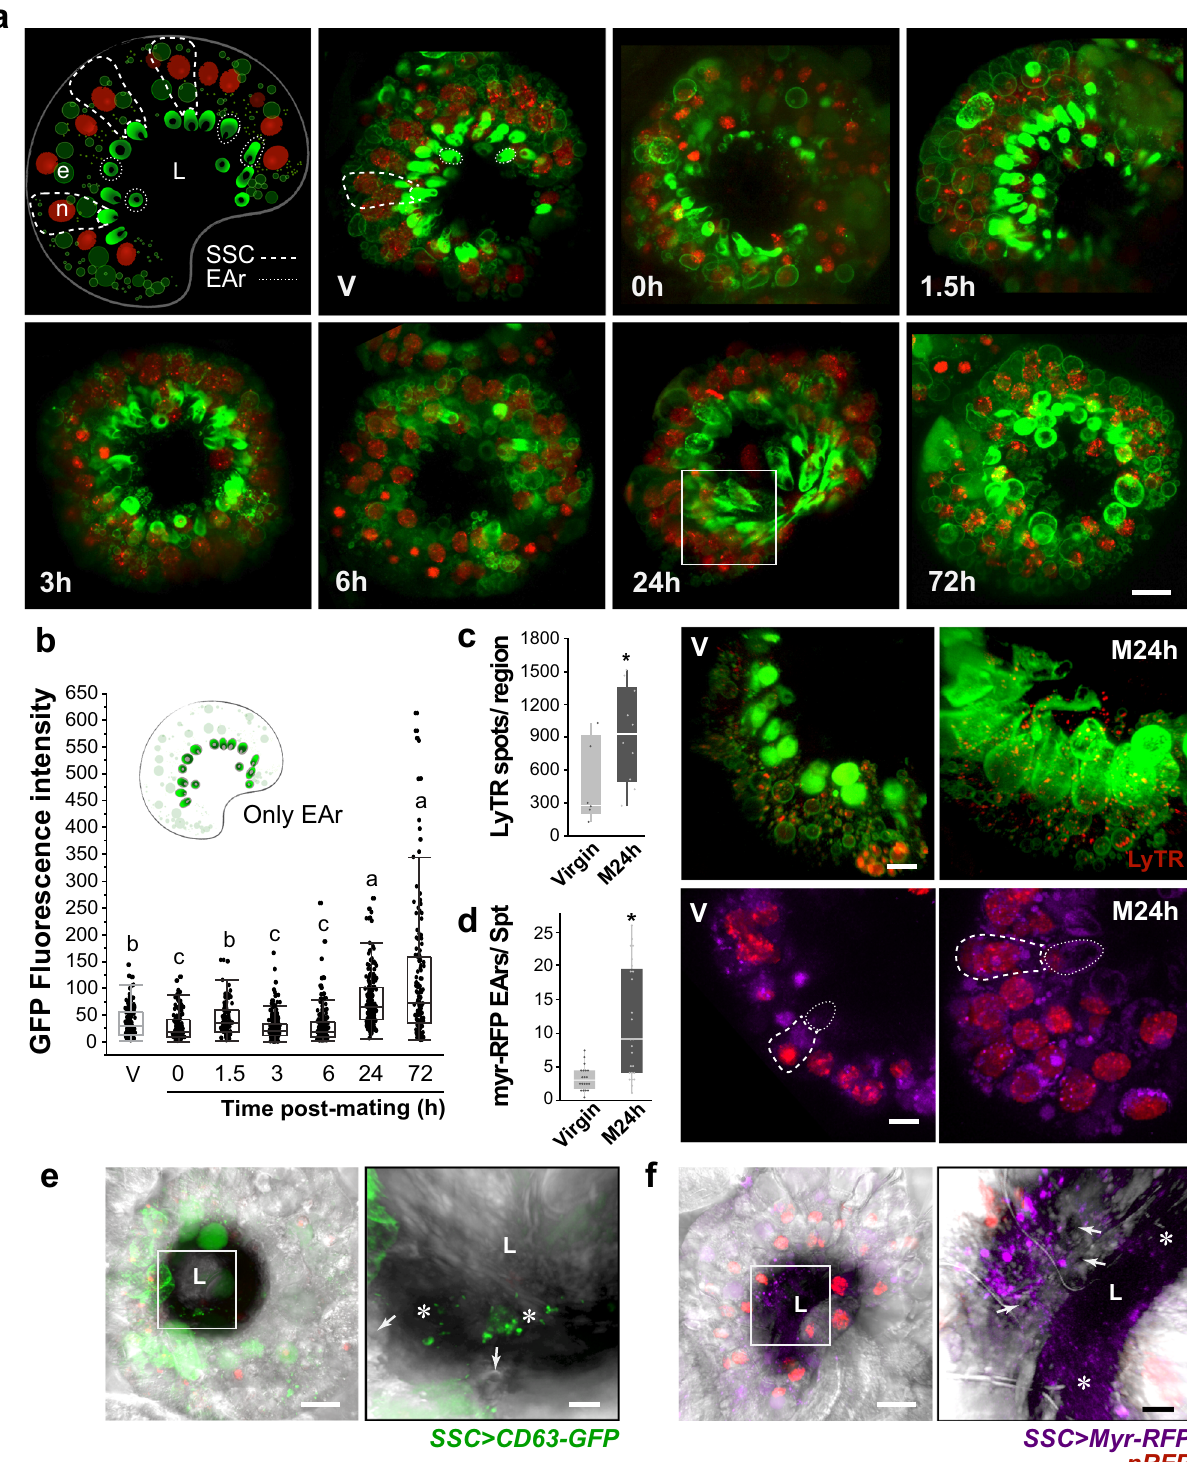
positive spots in the SSC plausibly suggests an increase of late endosomes/MVB 34 , a process that requires acidi fi cation 35 . To verify the mating effect detected upon expressing CD63-GFP in the SSC, we expressed in the SSC a myristoylated RFP (myr-RFP) co-translational modi fi cation that targets proteins to membranes 36 . The myristoylation consensus sequence fused to RFP labeled intracellular membranes in the SSC and as